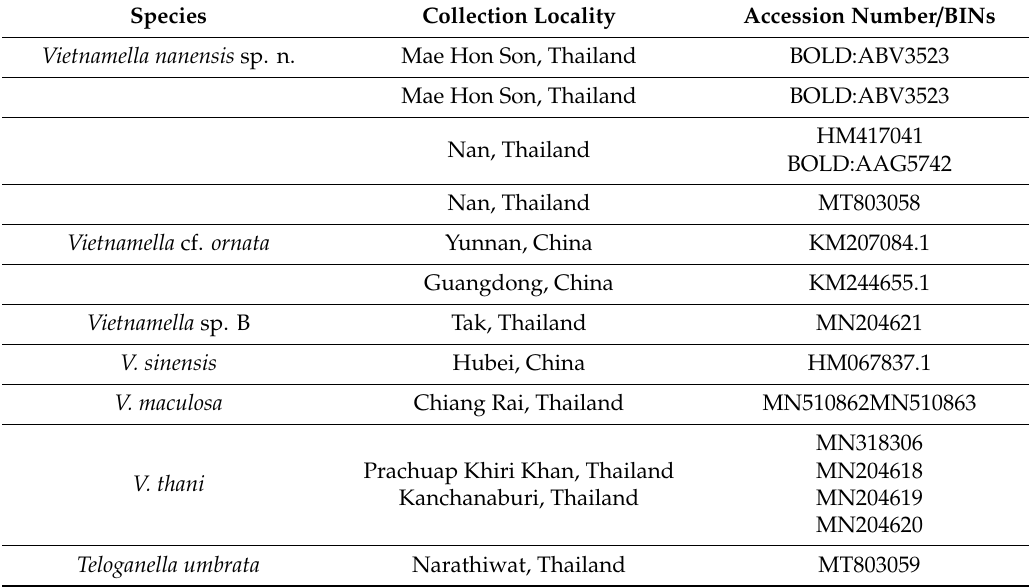
Table 1. The Kimura 2-parameter (K2P) genetic distance was analyzed to confirm species delimitation. Table 1. The mitochondrial cytochrome c oxidase subunit I (COI) sequences for molecular analysis.